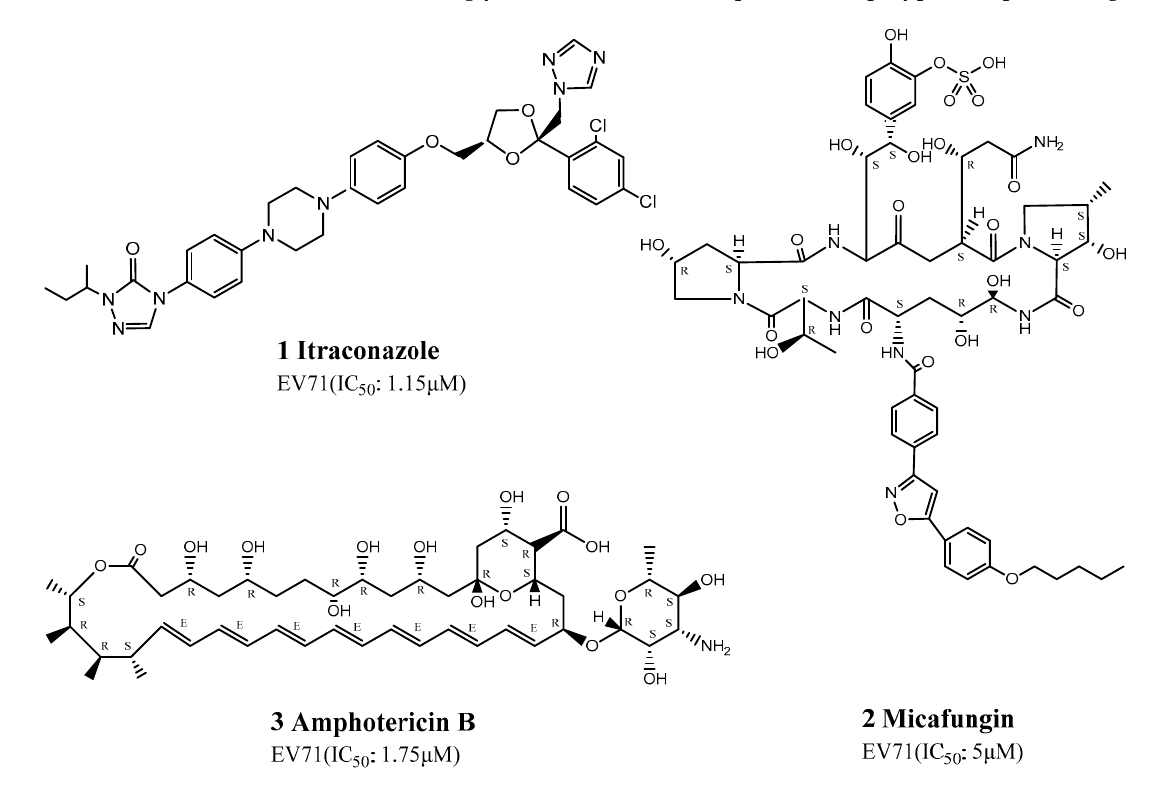
Figure 1. Structures of antifungal drugs.